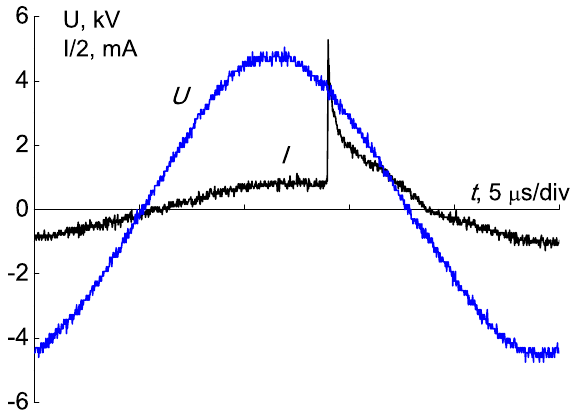
Figure 3. Discharge voltage and current with time in helium for U = 5